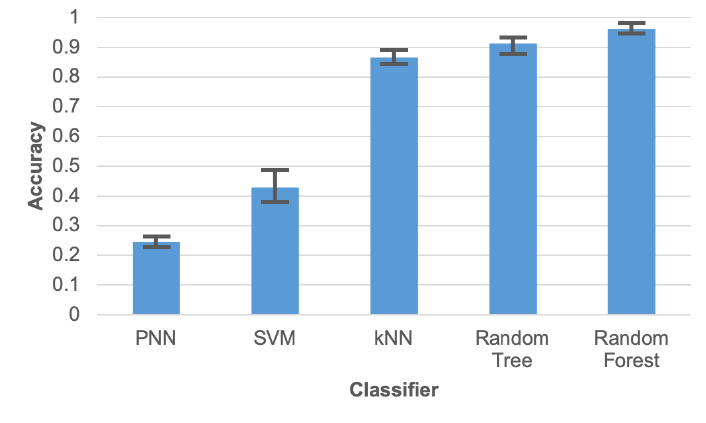
Figure 7. Accuracy of human activity recognition for compared machine learning algorithms.